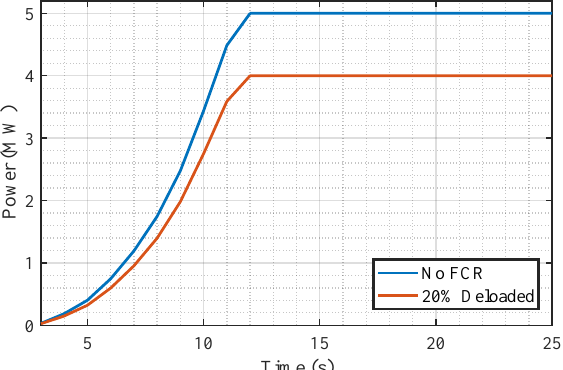
Figure 9. Power reference for the no FCR and 20% de-loaded cases.